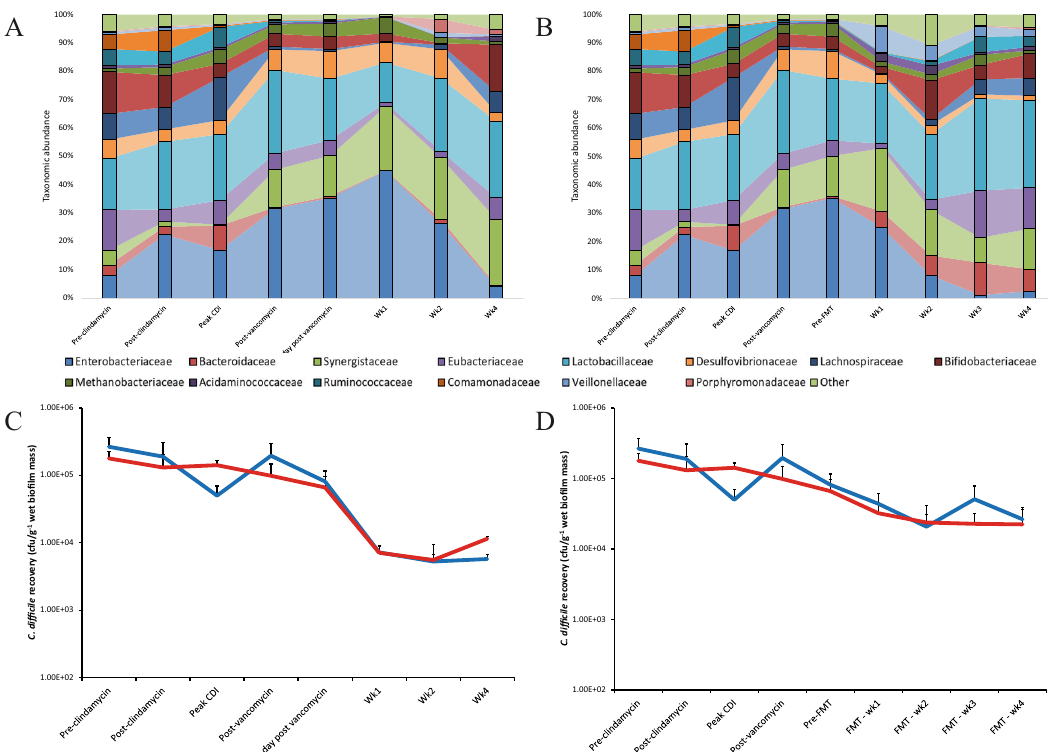
Fig. 2 Changes in the bio fi lm-associated microbiota during CDI and recurrence. Percentage taxonomic abundance of bacterial families isolated from bio fi lm support structures taken from recurrence (rCDI) model ( A ) or the FMT model ( B ). Graphs constructed using mean (of least 3 support structures/time point) percent abundance of bacterial OTUs assigned to the family taxonomic level. Enumeration of bio fi lm- associated C. dif fi cile (vegetative cells – red lines, spores – blue lines) from support structures from the recurrence ( C ) and FMT models ( D ). Results shown as mean log 10 cfu/g wet bio fi lm mass from two biological replicates and at least four support structures. Error bars represent the standard